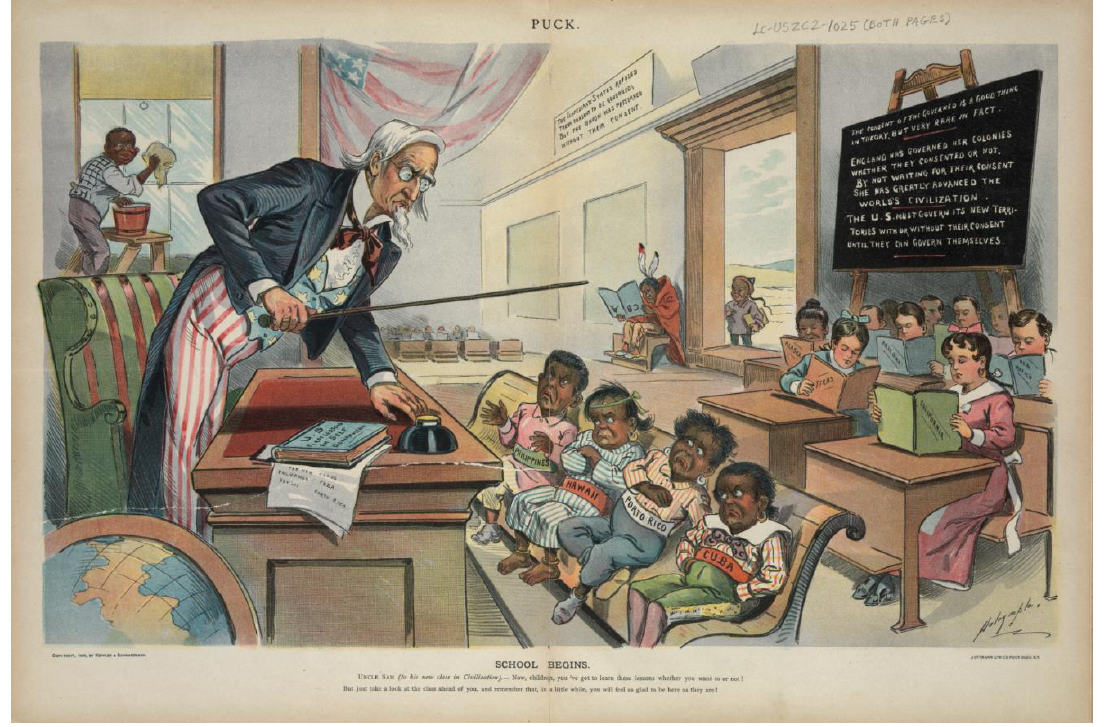
Figure 1. “School Begins” ( Puck 1899). Image source: Library of Congress (https://www.loc.gov/pictures/item/2012647459/). Public domain.